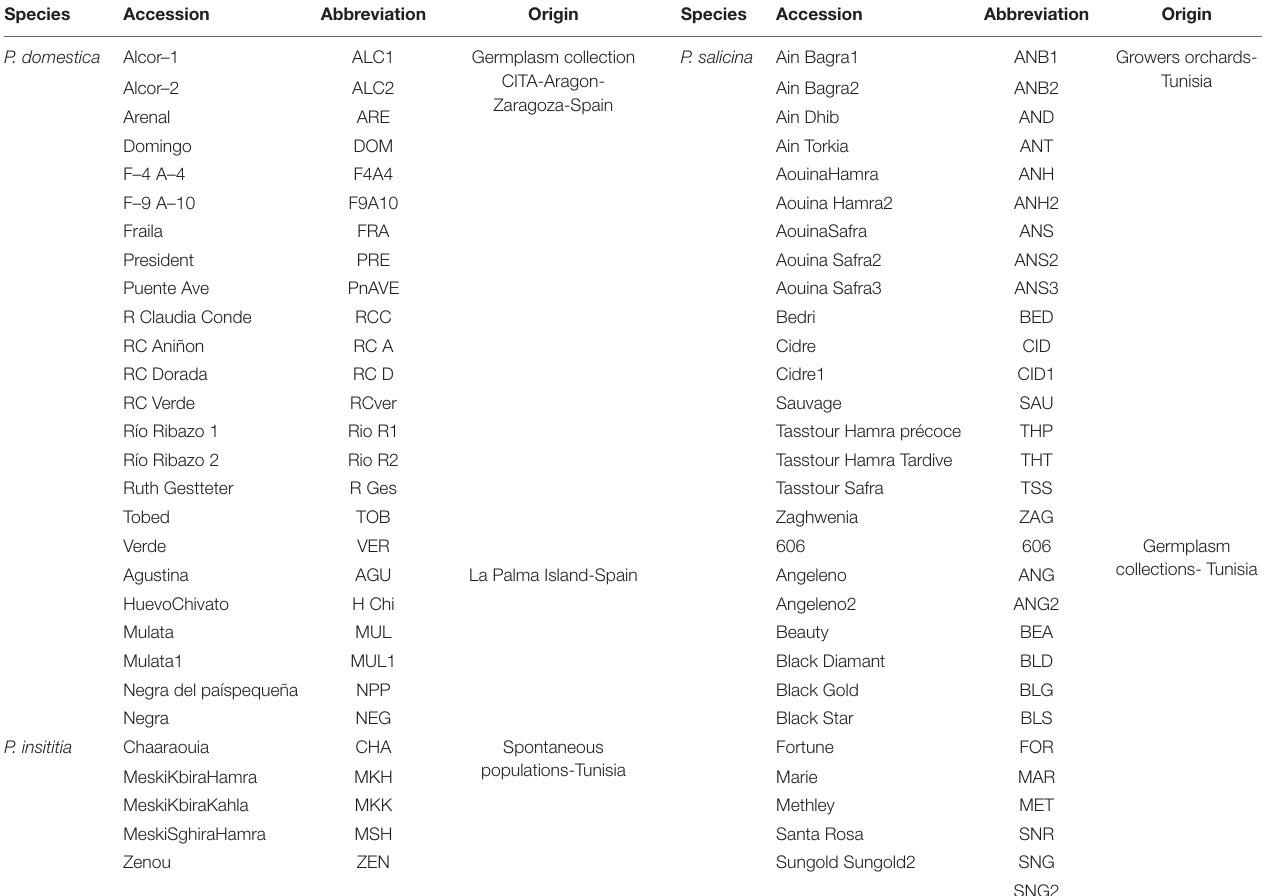
TABLE 1 | Names and origin of plum accessions analyzed in this work.